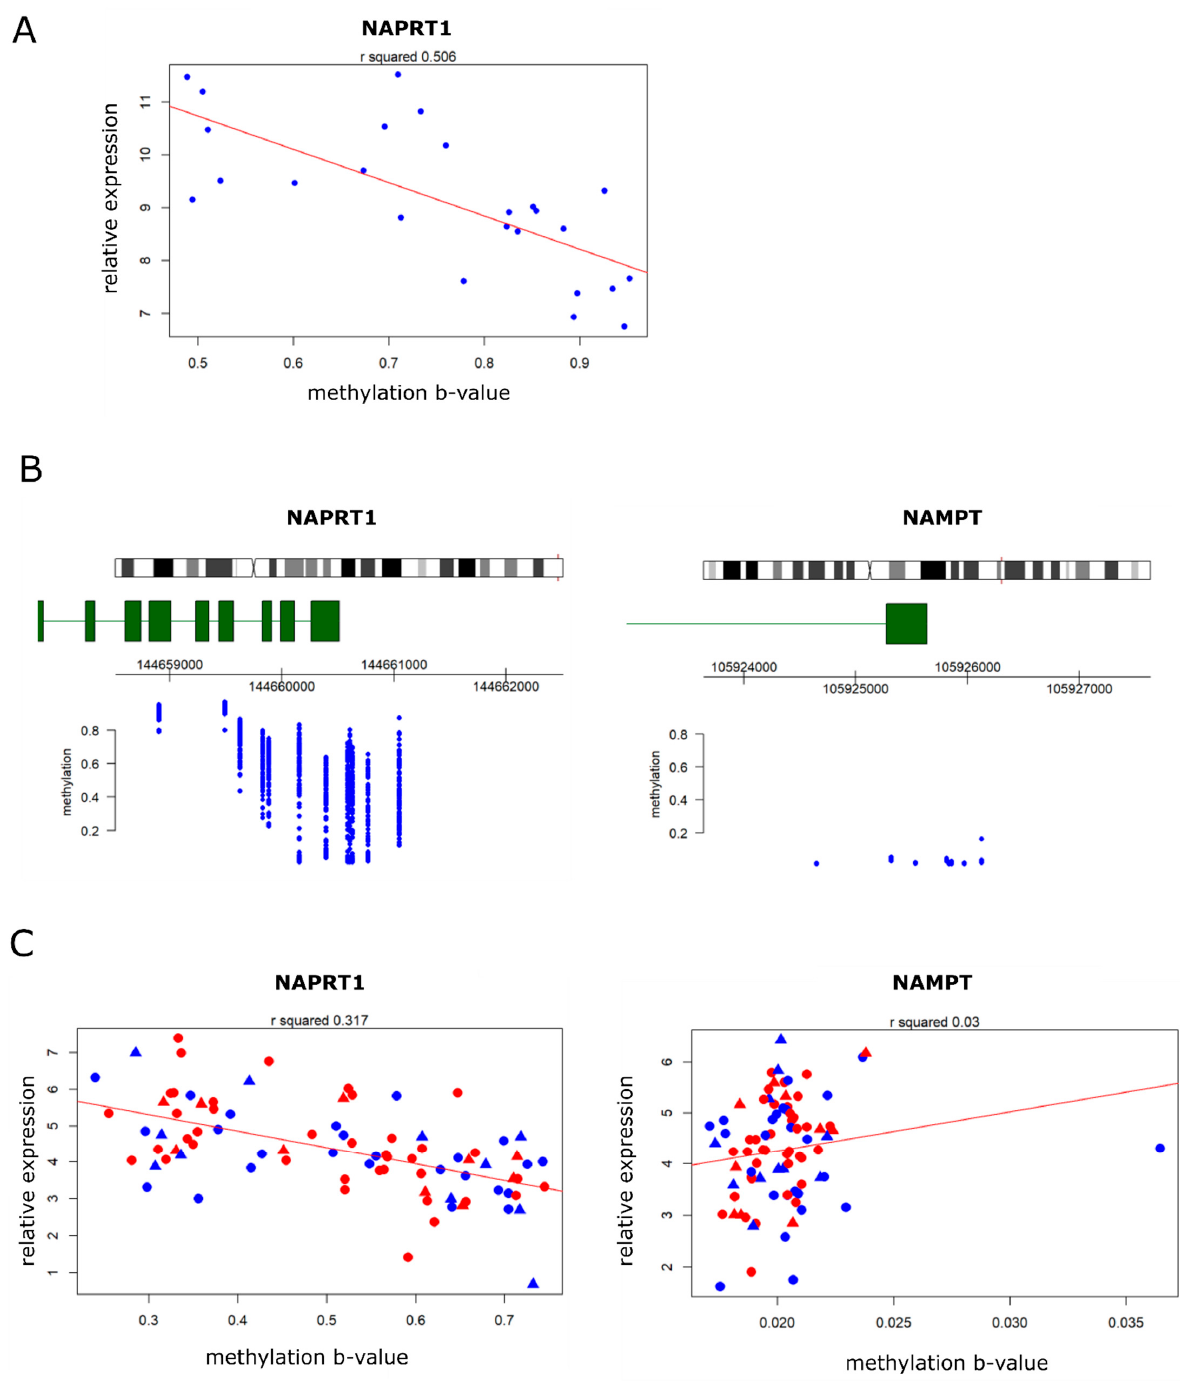
Figure 5. NAPRT promotor methylation correlates with low NAPRT1 expression in osteosarcoma. ( A ) In OS cell lines, methylation of NAPRT1 correlates with the low expression of NAPRT1. ( B ) Transcription start site of NAPRT1, and not NAMPT, has areas of methylation in a subset of osteosarcoma tumors. ( C ) High methylation correlates with the low expression of NAPRT1 in osteosarcomas. NAMPT gene expression does not correlate with the methylation status. Red = male, blue = female, circle = non-metastatic, triangle = metastatic.